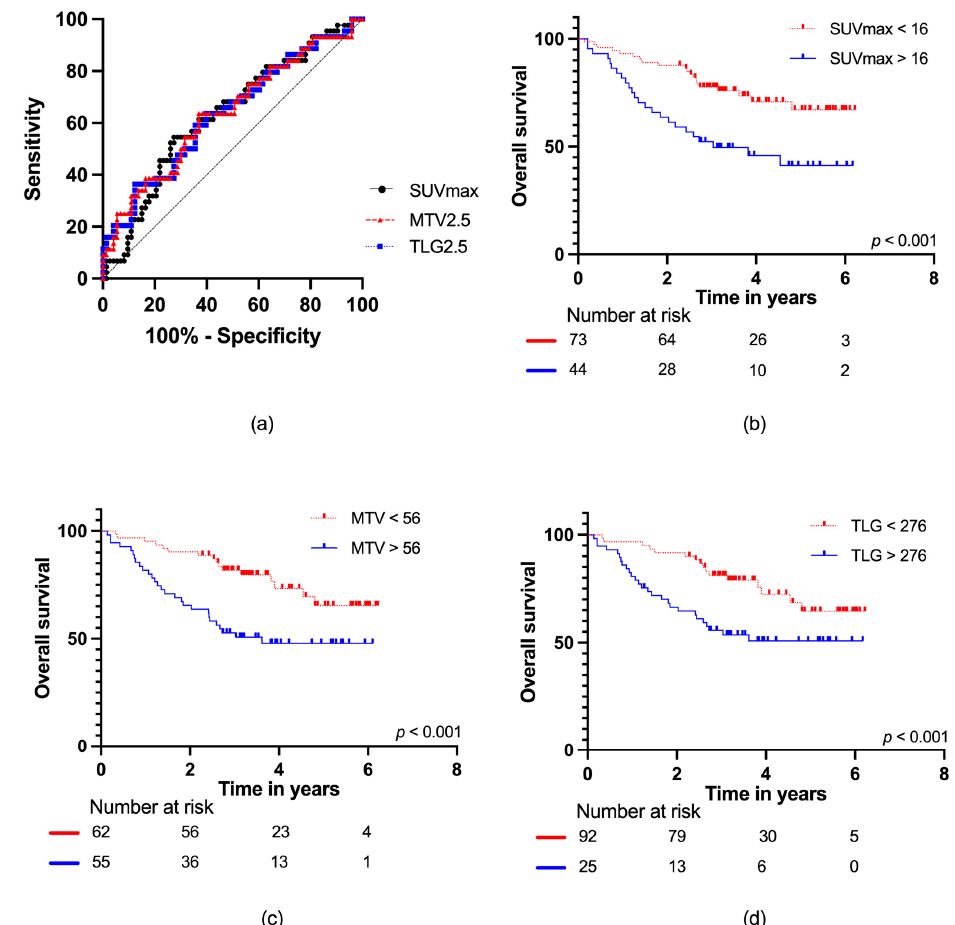
Figure 4. ( a ) ROC curves for SUVmax, MTV2.5, and TLG2.5 in localized disease; Kaplan–Meier survival curves with number at risk at baseline, two, four, and six years for ( b ) SUVmax; ( c ) MTV2.5; and ( d ) TLG2.5.